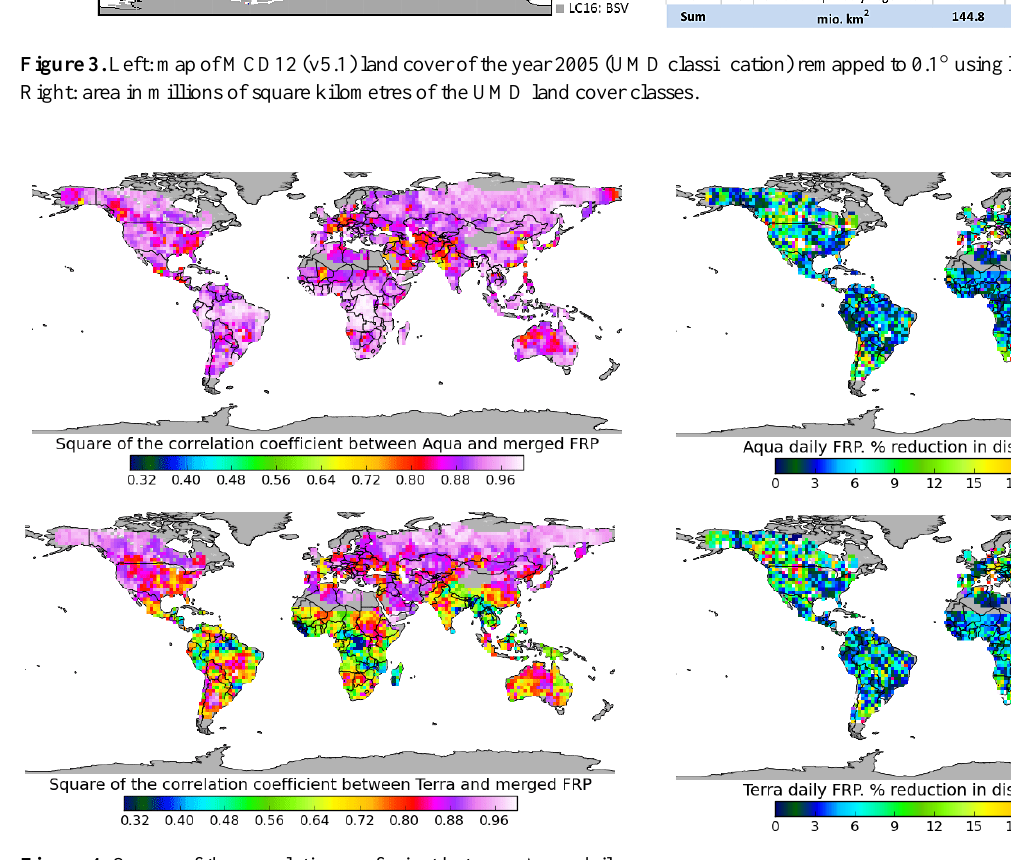
Figure 5. Reduction in per cent of the distance between daily FRP from Aqua (top), Terra (bottom) and merged FRP by the non-linear regression as compared to the linear